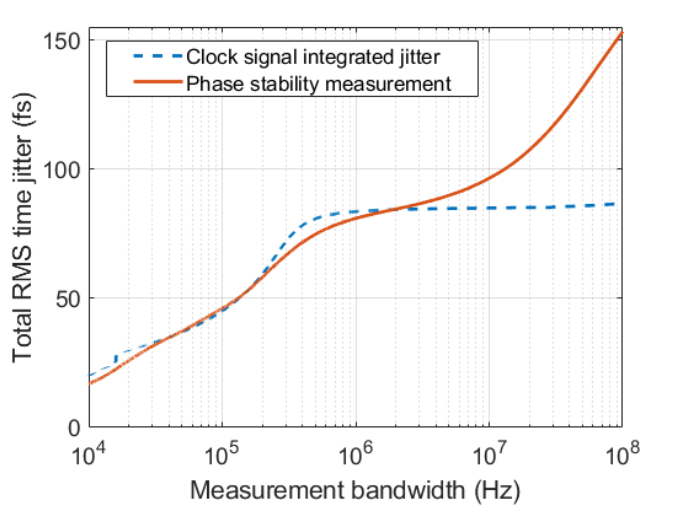
Figure 12. Comparison of rms time deviation calculated from the measured phase stability against the integrated sampling clock jitter.